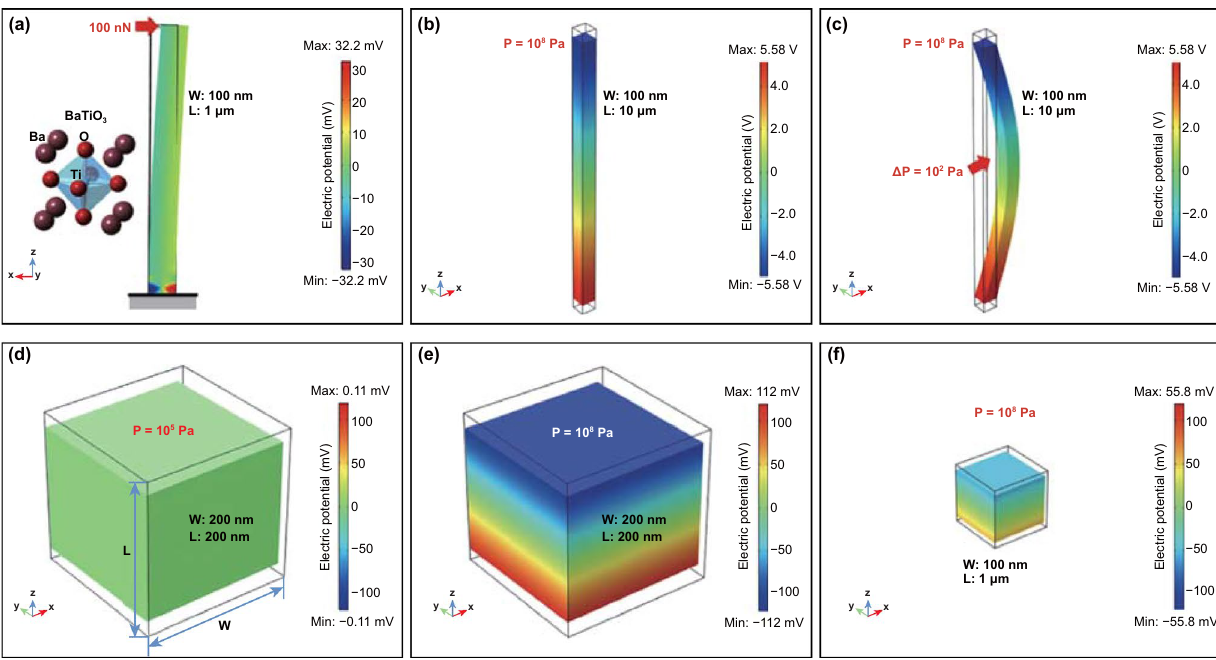
Fig. 2 a A BTO nanowire with a diameter of 100 nm and a length of 1 μm stressed on the top by a lateral force with 100 nN where the bottom side is grounded and fixed. b A BTO nanowire under an axial compression with the pressure of 10 8 Pa. c A BTO nanowire stressed at middle part under a lateral deformation with the pressure of 10 8 Pa. A BTO nanoparticle with a size of 200 nm under the pressure of d 10 5 Pa and e 10 8 Pa. f A BTO nanoparticle with a size of 100 nm under the pressure of 10 8 Pa. Reproduced with permission [101]. Copyright 2018,